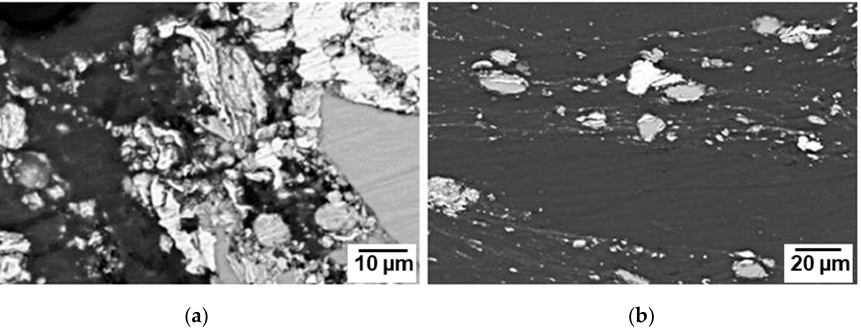
Figure 10. SEMimagesofcross-sectionofspecimen3,showing( a )aclusteredregionand( b )areinforcedregion. Figure 10. SEM images of cross-section of specimen 3, showing ( a ) a clustered region and ( b ) a reinforced region.